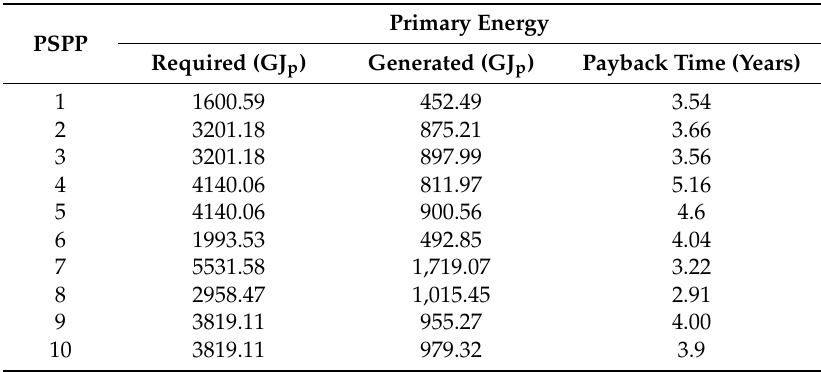
Table 7. Energy payback time (EPBT) for the solar PV power plants.